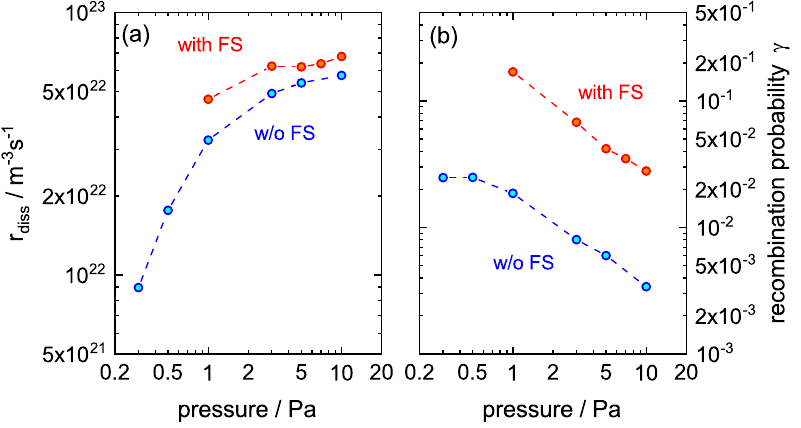
Figure 4. ( a ) Estimation of the dissociation rate according to Equation (3) with and without Fara- day shield and at varying pressure. ( b ) Wall recombination probability γ required to balance the dissociation rate depicted in part ( a